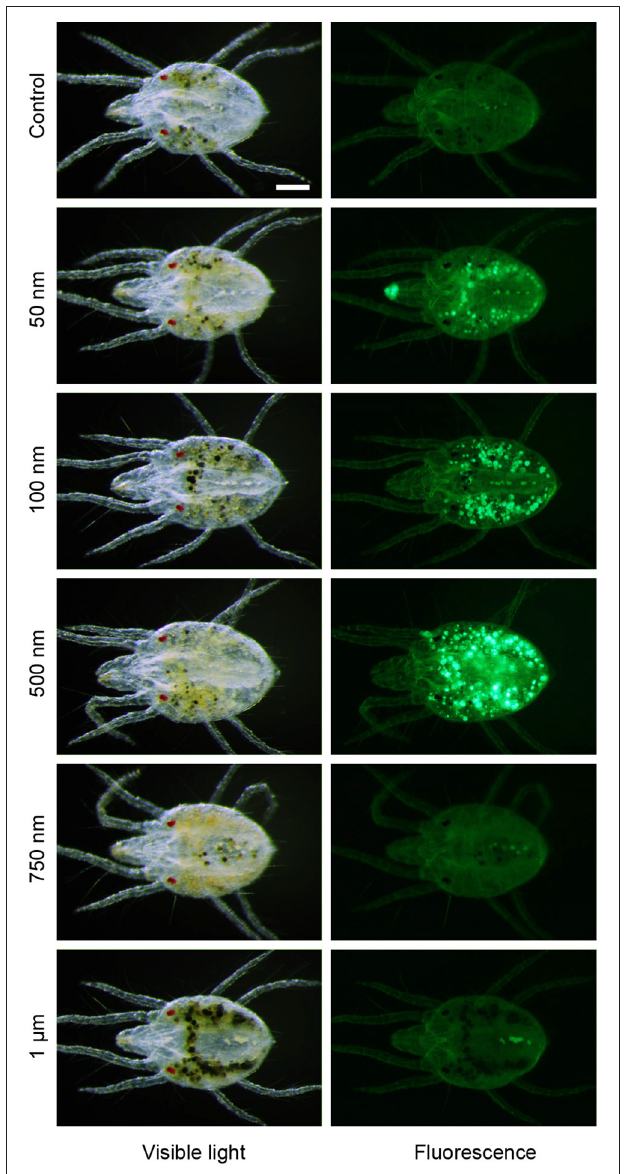
FIGURE 2 | Size limitation of spider mite feeding apparatus. Accumulation of fluorescent microspheres of 50nm to 1 µ m in diameter in midgut of the spider mites after 24h feeding at 25 ◦ C. Scale bar: 100 µ